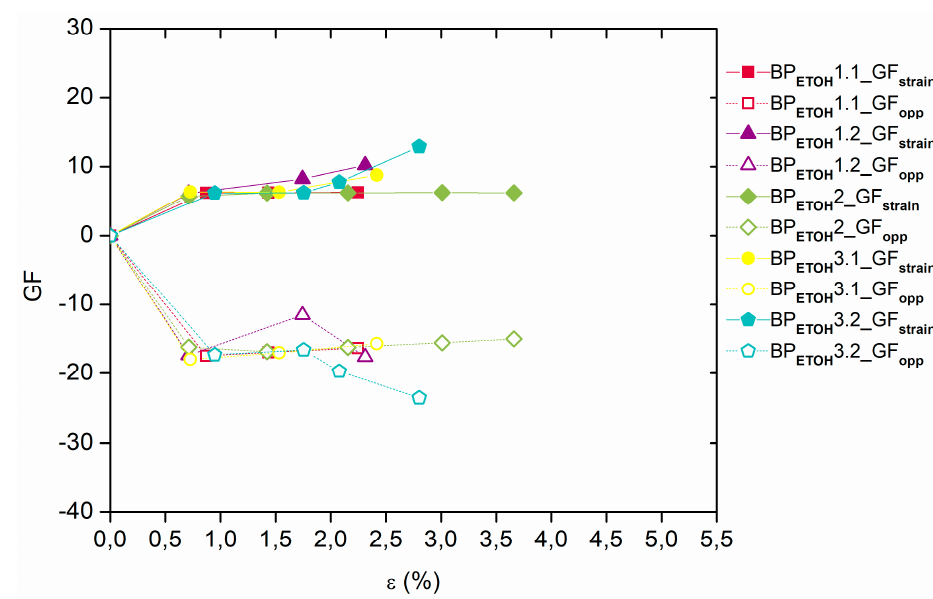
Figure 7. Gauge factor (GF) versus strain ε for the BP ETOH /PI samples (GF strain and GF opp values in axial strain and opposite (transverse) directions, respectively).